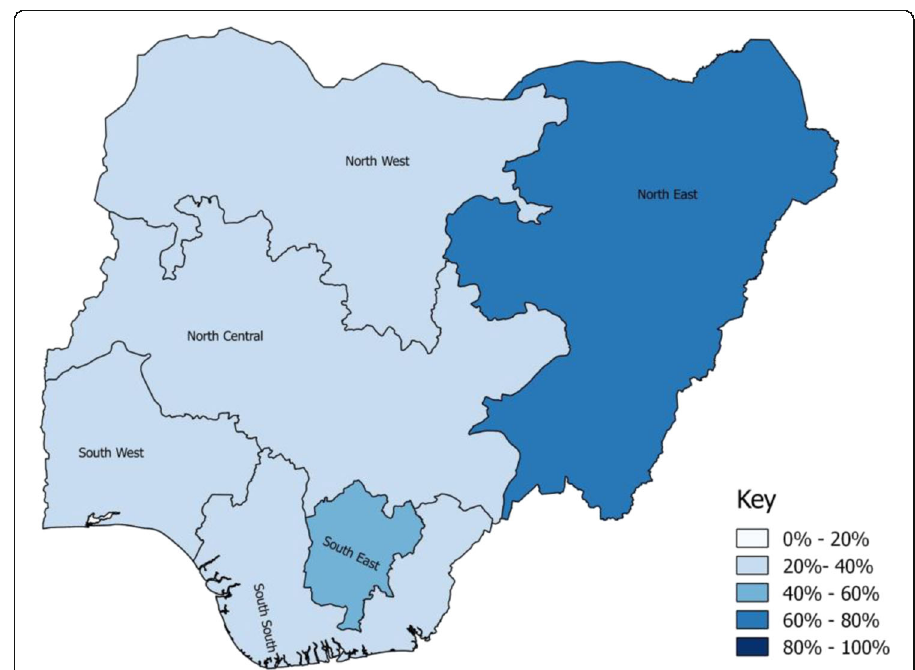
Fig. 6 Percentage of women believing that a husband is justified in beating his wife for any reason, by region, NDHS 2008